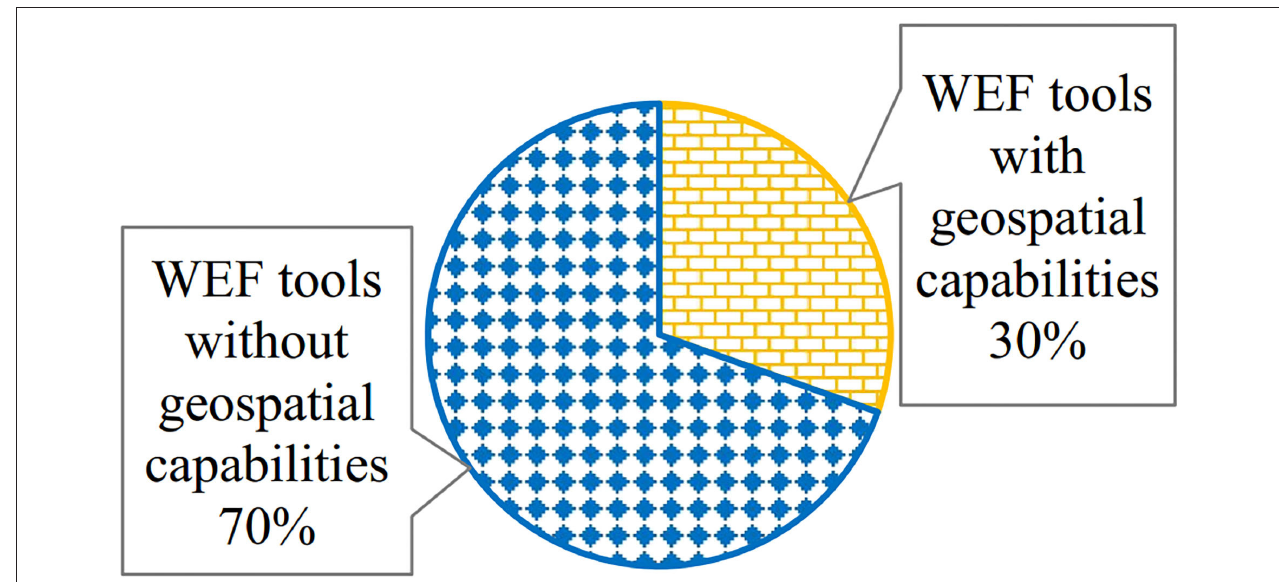
FIGURE 8 | WEF nexus tools and their geospatial